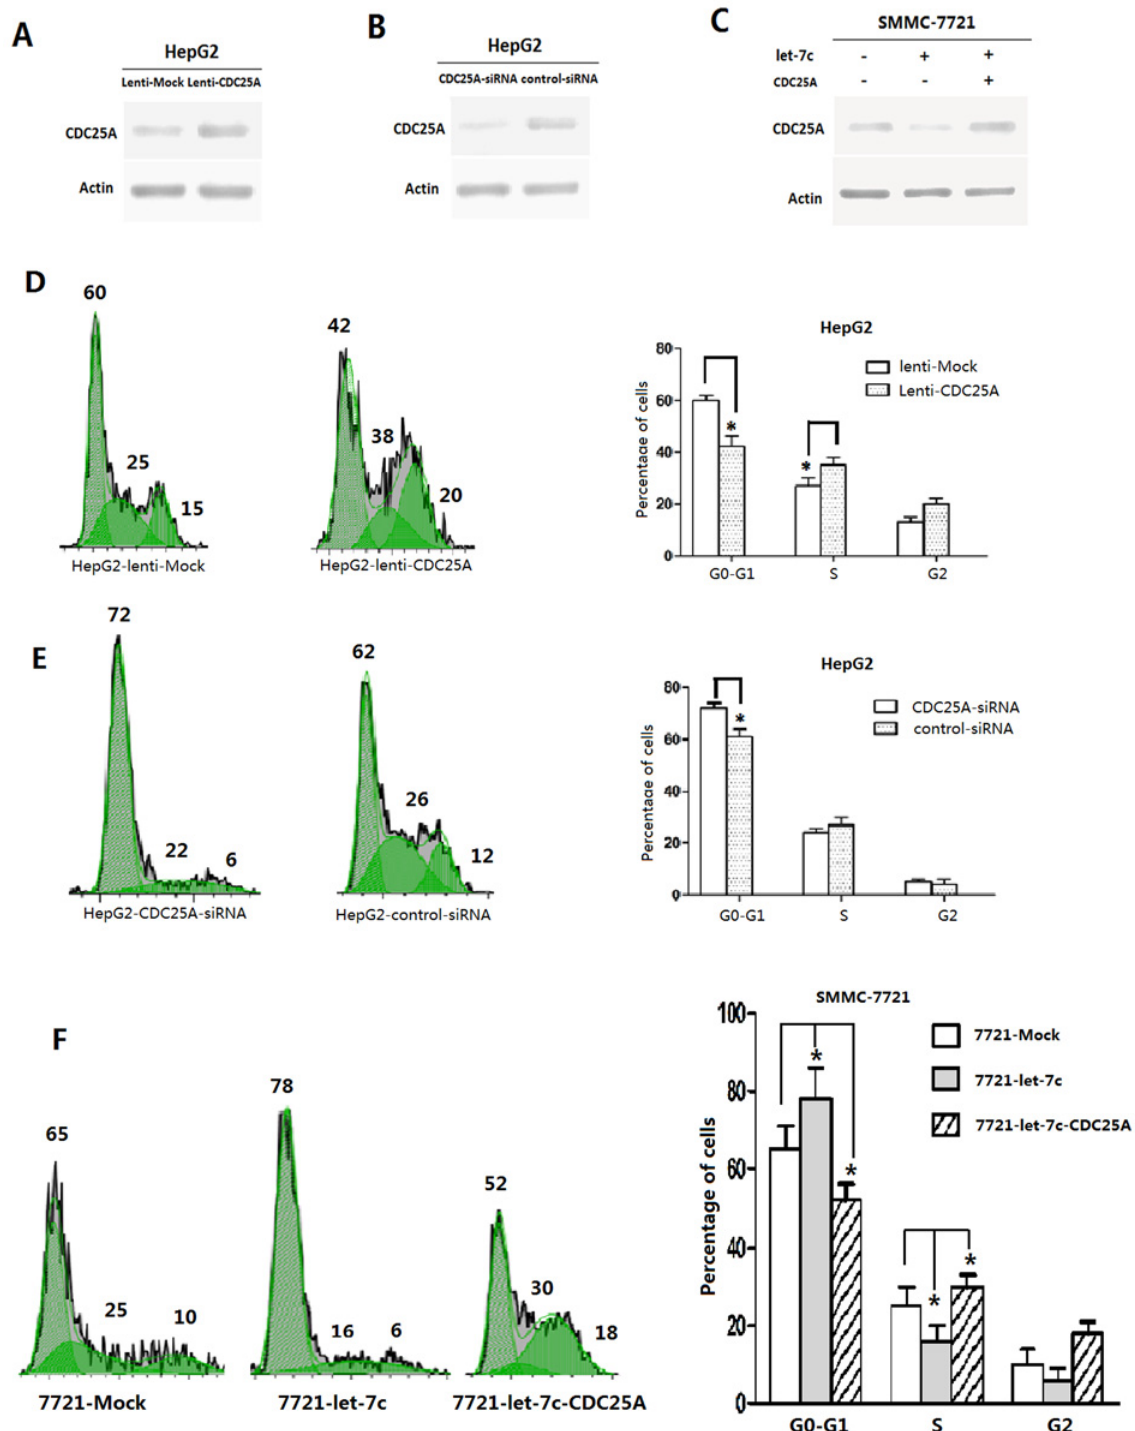
Fig 6. CDC25A induces the G1-to-S phase transition in HCC cells. (A,B) Western blotting of CDC25A protein expression in HepG2 cells infected/ transfected with lenti-CDC25A, lenti-control, CDC25A-siRNA or negative control-siRNA. (C) Western blot analysis of CDC25A expression in SMMC-7721 cells and SMMC-7721-let-7c stable cells with or without CDC25A * reintroduction. (D,E) Infection/transfection of HepG2 cells with lenti-CDC25A, lenti-control, CDC25A-siRNA or negative control-siRNA was performed to investigate the effects of CDC25A on the HCC cell cycle. Representative images are shown. (F) Cell cycle assays of SMMC-7721 cells or SMMC-7721-let-7c stable cells with or without CDC25A * reintroduction. Restoration of CDC25A significantly